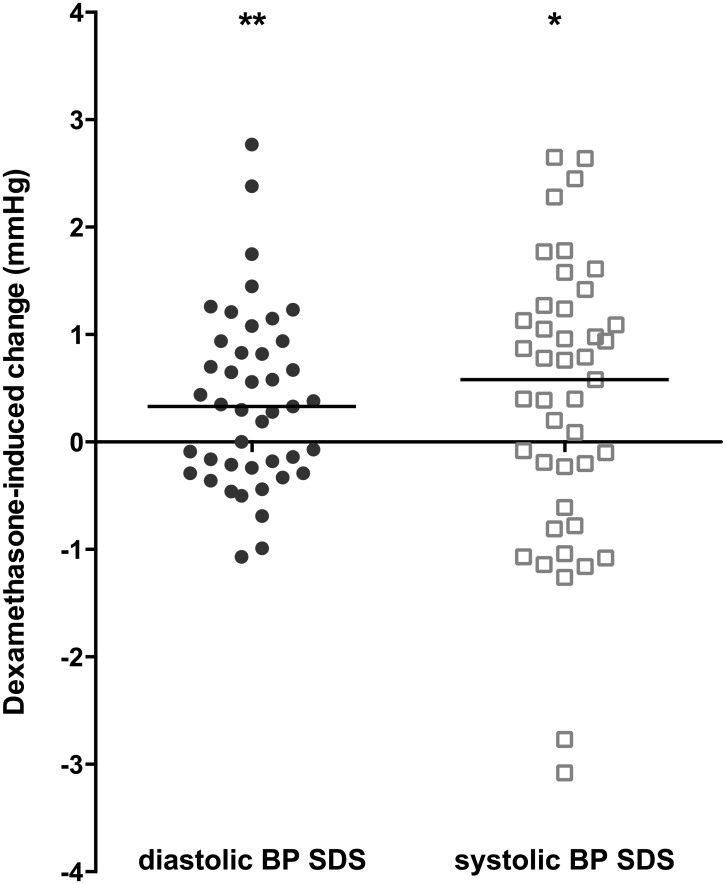
Blood pressure.Dexamethasone-induced changes in diastolic and systolic blood pressure (BP) SDS values after four days of dexamethasone treatment. N = 43. * = P<0.05 and ** = P<0.01 (Wilcoxon signed-rank test). The horizontal lines indicate the median change.